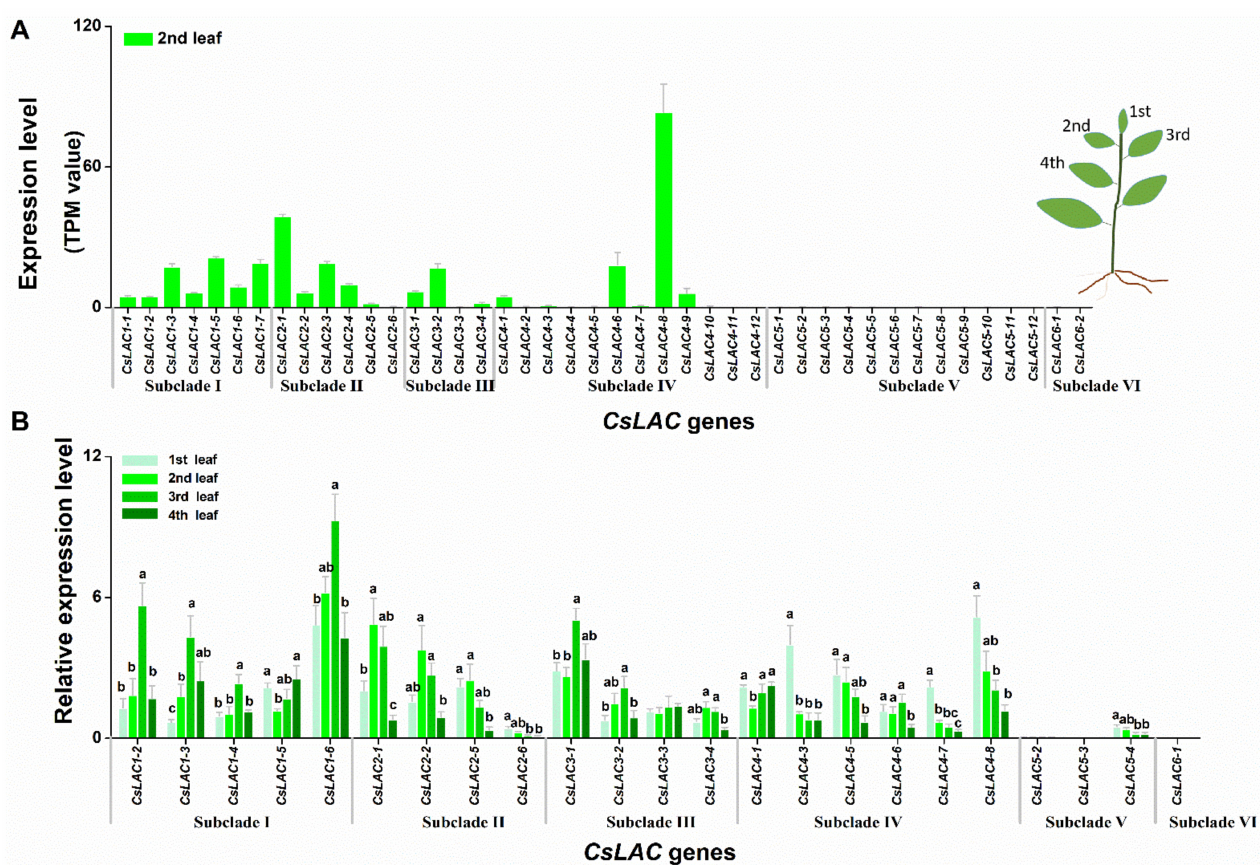
Figure 5. Expression patterns of CsLAC s in leaves of C. sinensis cv ‘Longjing43 (cid:48) cultivars. ( A ) Expression levels of 43 CsLAC s in the 2nd leaves and their abundance was evaluated by converting read count to TPM. Inset: Schematic illustration of sample collection. ( B ) Expression patterns of CsLAC s in leaves at different stages of maturity (1st, 2nd, 3rd and 4th leaf). Different letters indicate significant differences among different maturity stages ( p < 0.05, Turkey’s honest significant difference (HSD) post-hoc